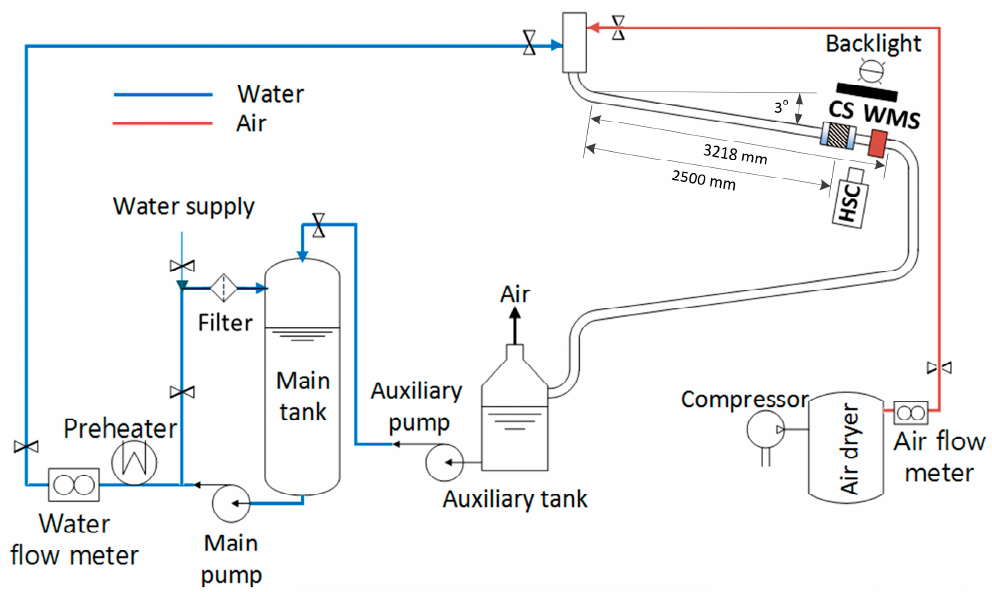
Figure 5. Schematic diagram of the air-water two-phase flow loop.